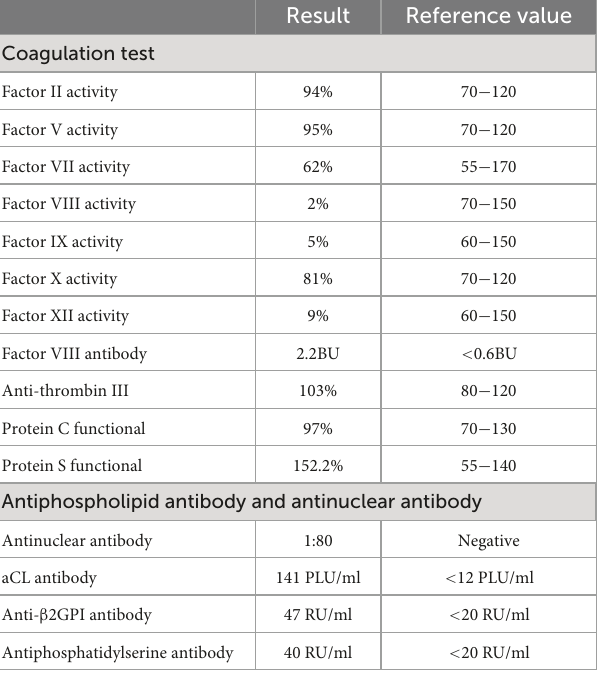
TABLE 3 Result of coagulation factor and antiphospholipid antibody.